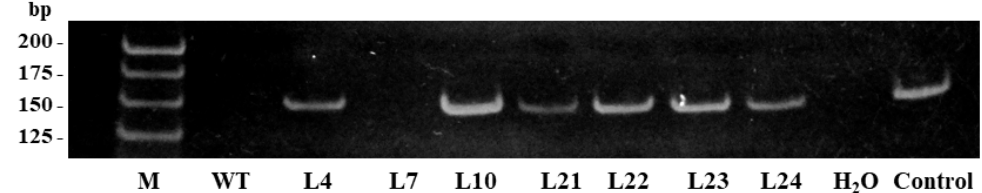
Figure 2. RT-PCR amplicons generated from cDNA of leaves of transgenic tobacco transformed with VlvSTS gene. M—HyperLadder 25 bp DNA molecular weight marker (Meridian Life Bioscience, Memphis, USA), WT—nontransformed tobacco, L4–L24—transgenic tobacco lines transformed with VlvSTS gene.